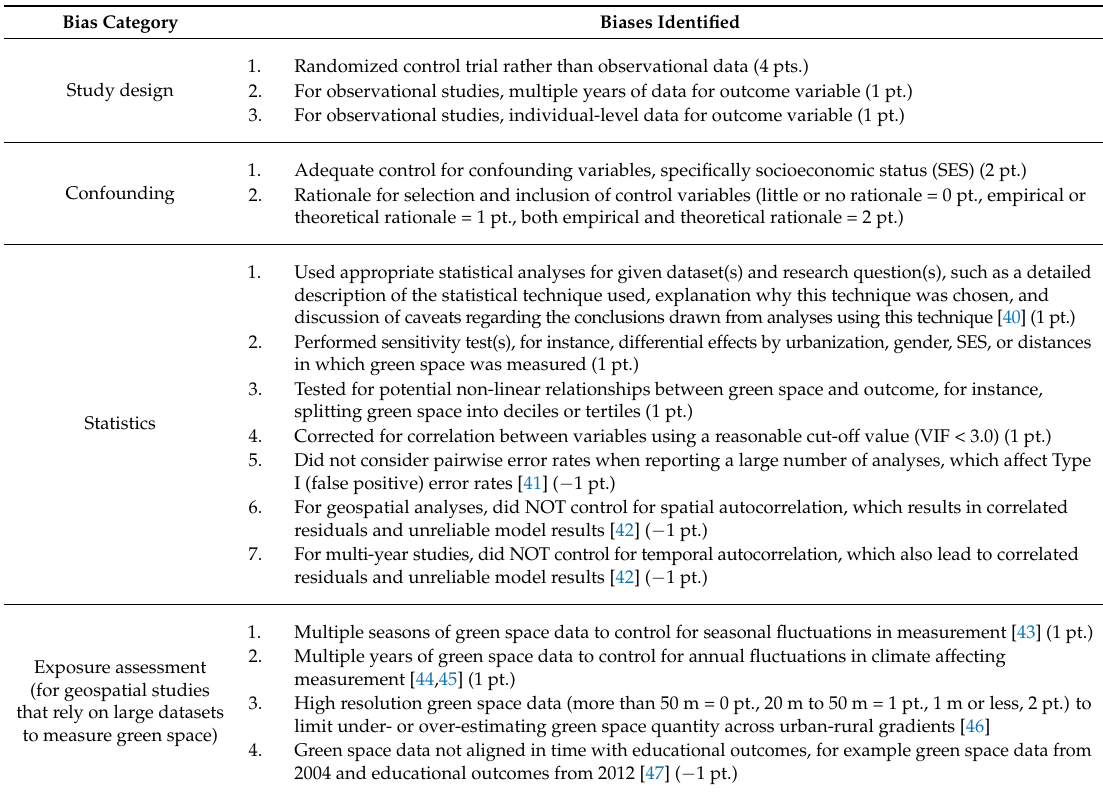
Table 1. Methodological biases in sampled